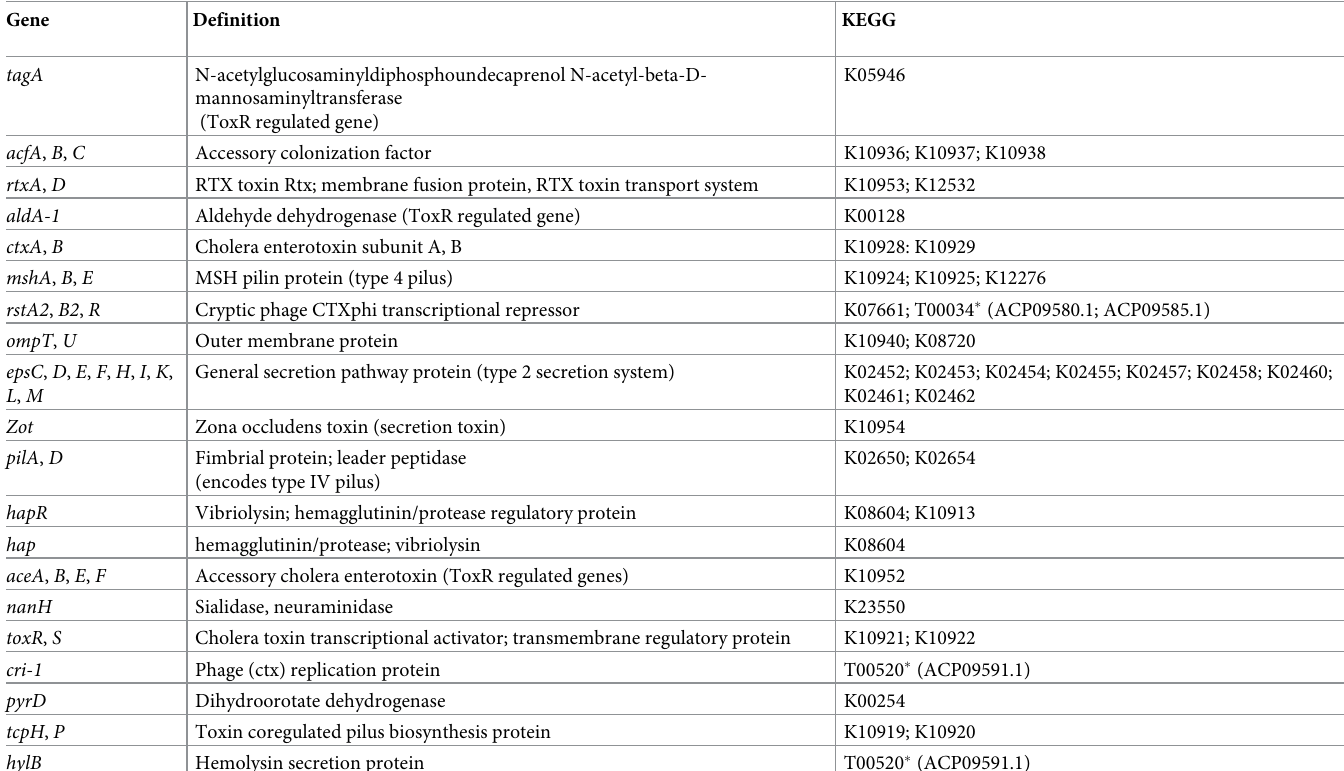
Table 2. Virulence genes of V . cholerae that were detected in the metagenomic analyses of the three studied C . ramosus larvae. For each group of genes, the definition of the genes and Kyoto Encyclopedia of Genes and Genomes (KEGG) numbers (when available), are shown. Most of these genes are in chromosome I and some are in chromosome II. See also S3 Fig KEGG is a database for identifying high-level functions and utilities of biological systems [36]. � For genes that lack a KEGG number, the protein ID is given